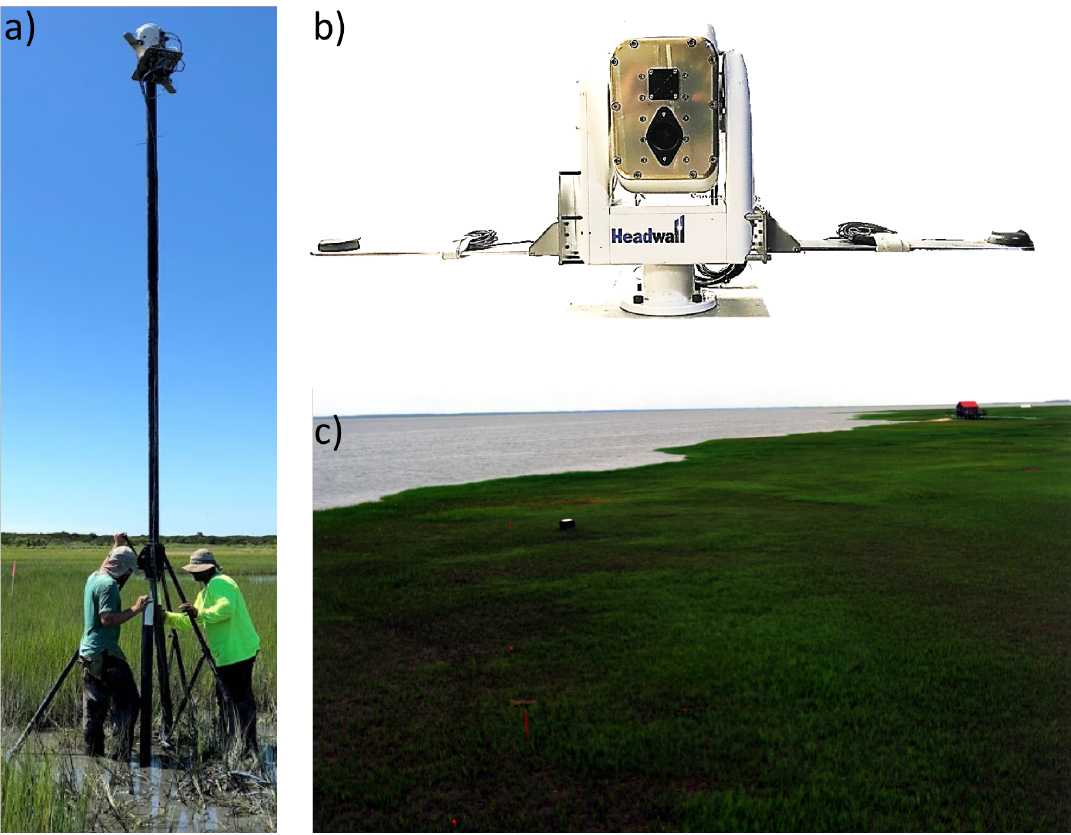
Figure 2. ( a ) Our HSI system being deployed in the field atop our BlueSky telescopic mast. ( b ) The different components of the HSI system. The Headwall hyperspectral sensor is housed within a maritime-rated General Dynamics Vector 20 pan-tilt unit. Our HSI system also incorporates a Vectornav VN-300 IMU-GPS to provide pointing information and GPS time-stamps. ( c ) A typical hyperspectral image obtained by our system on Hog Island at the VCR